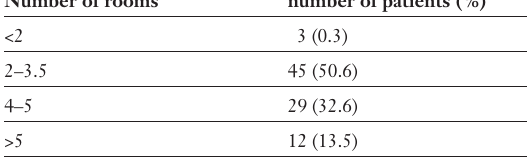
Number of rooms at patients’ home.